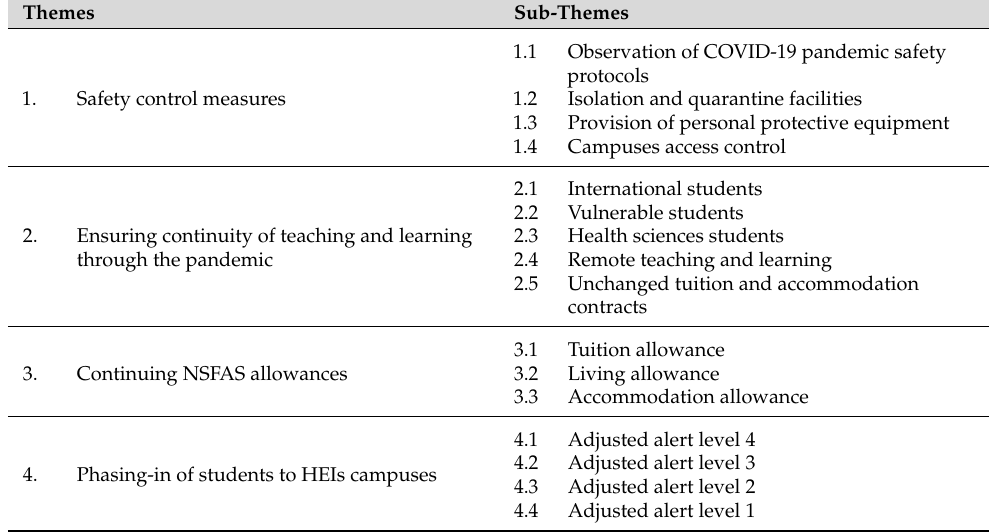
Table 1. Themes and sub-themes of the study